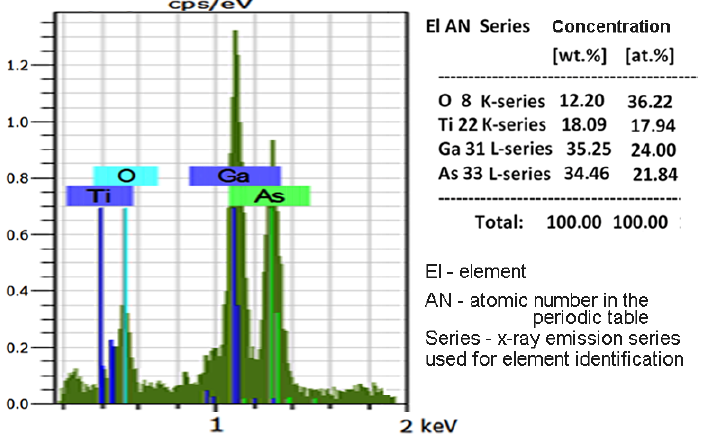
Figure 4. EDX analysis of a GaAs nanowire array coated with TiO 2 by ALD.